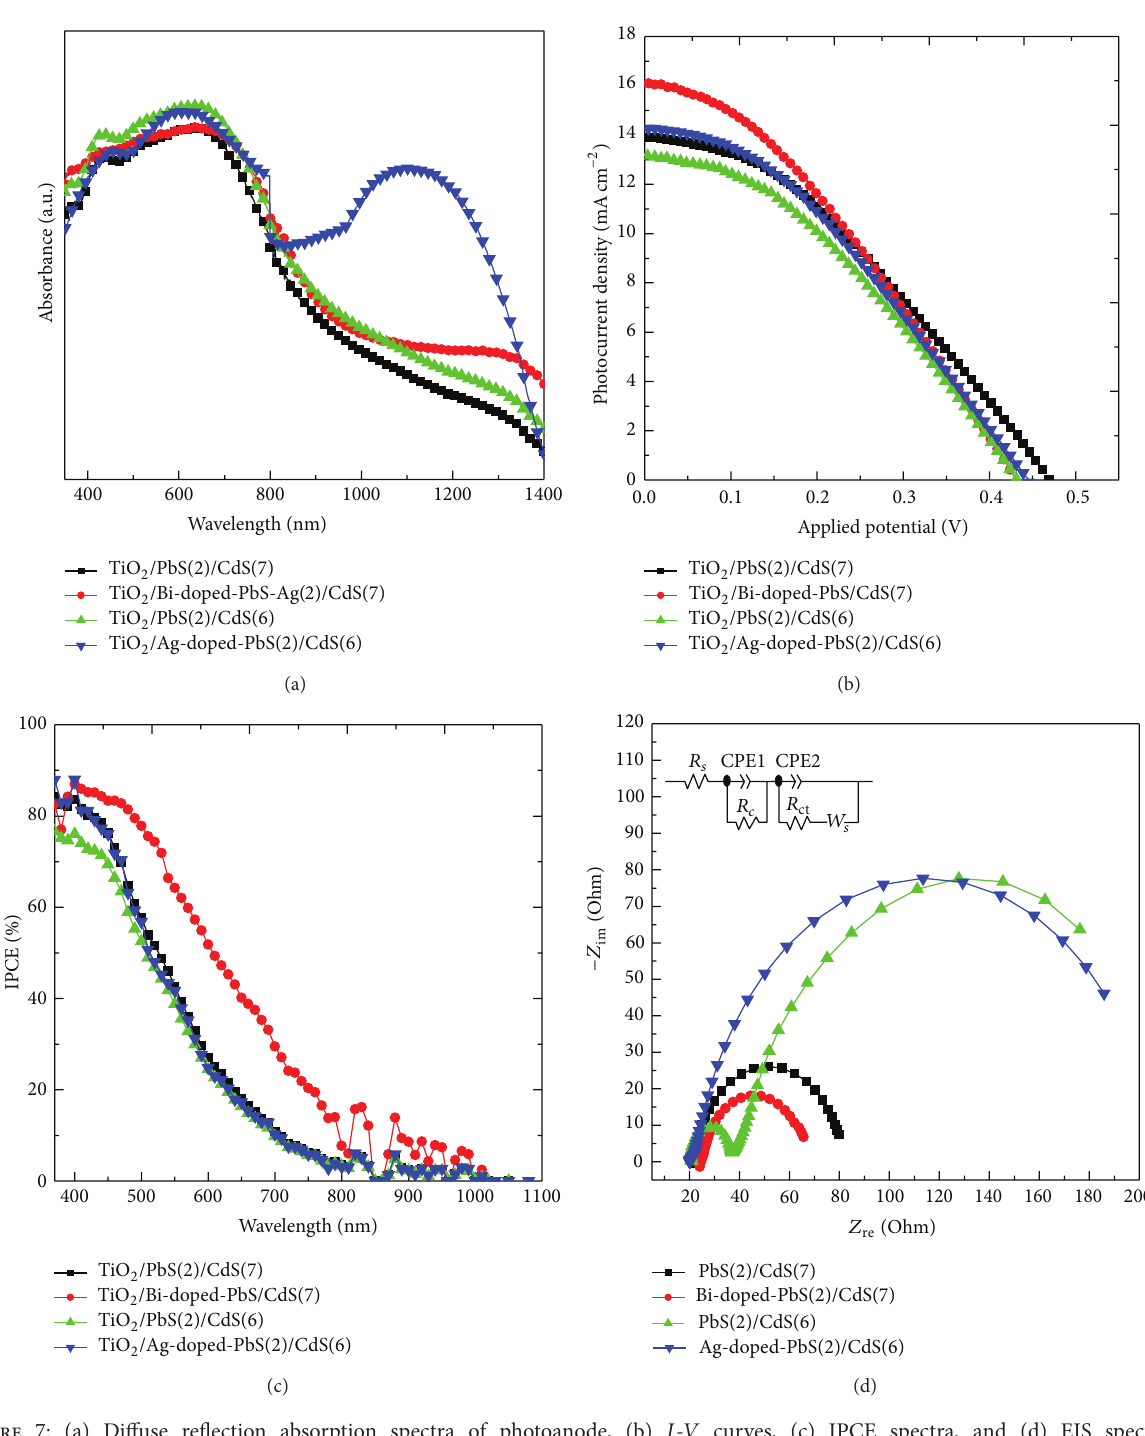
Figure 7: (a) Diffuse reflection absorption spectra of photoanode, (b) 𝐽 - 𝑉 curves, (c) IPCE spectra, and (d) EIS spectra of TiO 2 /PbS(2)/CdS(7), TiO 2 /Bi-doped-PbS(2)/CdS(7), TiO 2 /PbS(2)/CdS(6), and TiO 2 /Ag-doped-PbS(2)/CdS QDCSCs.